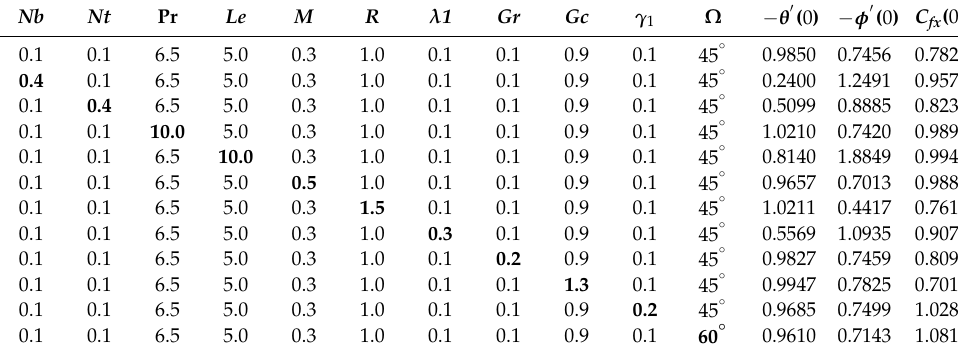
Table 2. Values of − θ (cid:48) ( 0 ) , − φ (cid:48) ( 0 ) , and C fx ( 0 ) . Nb